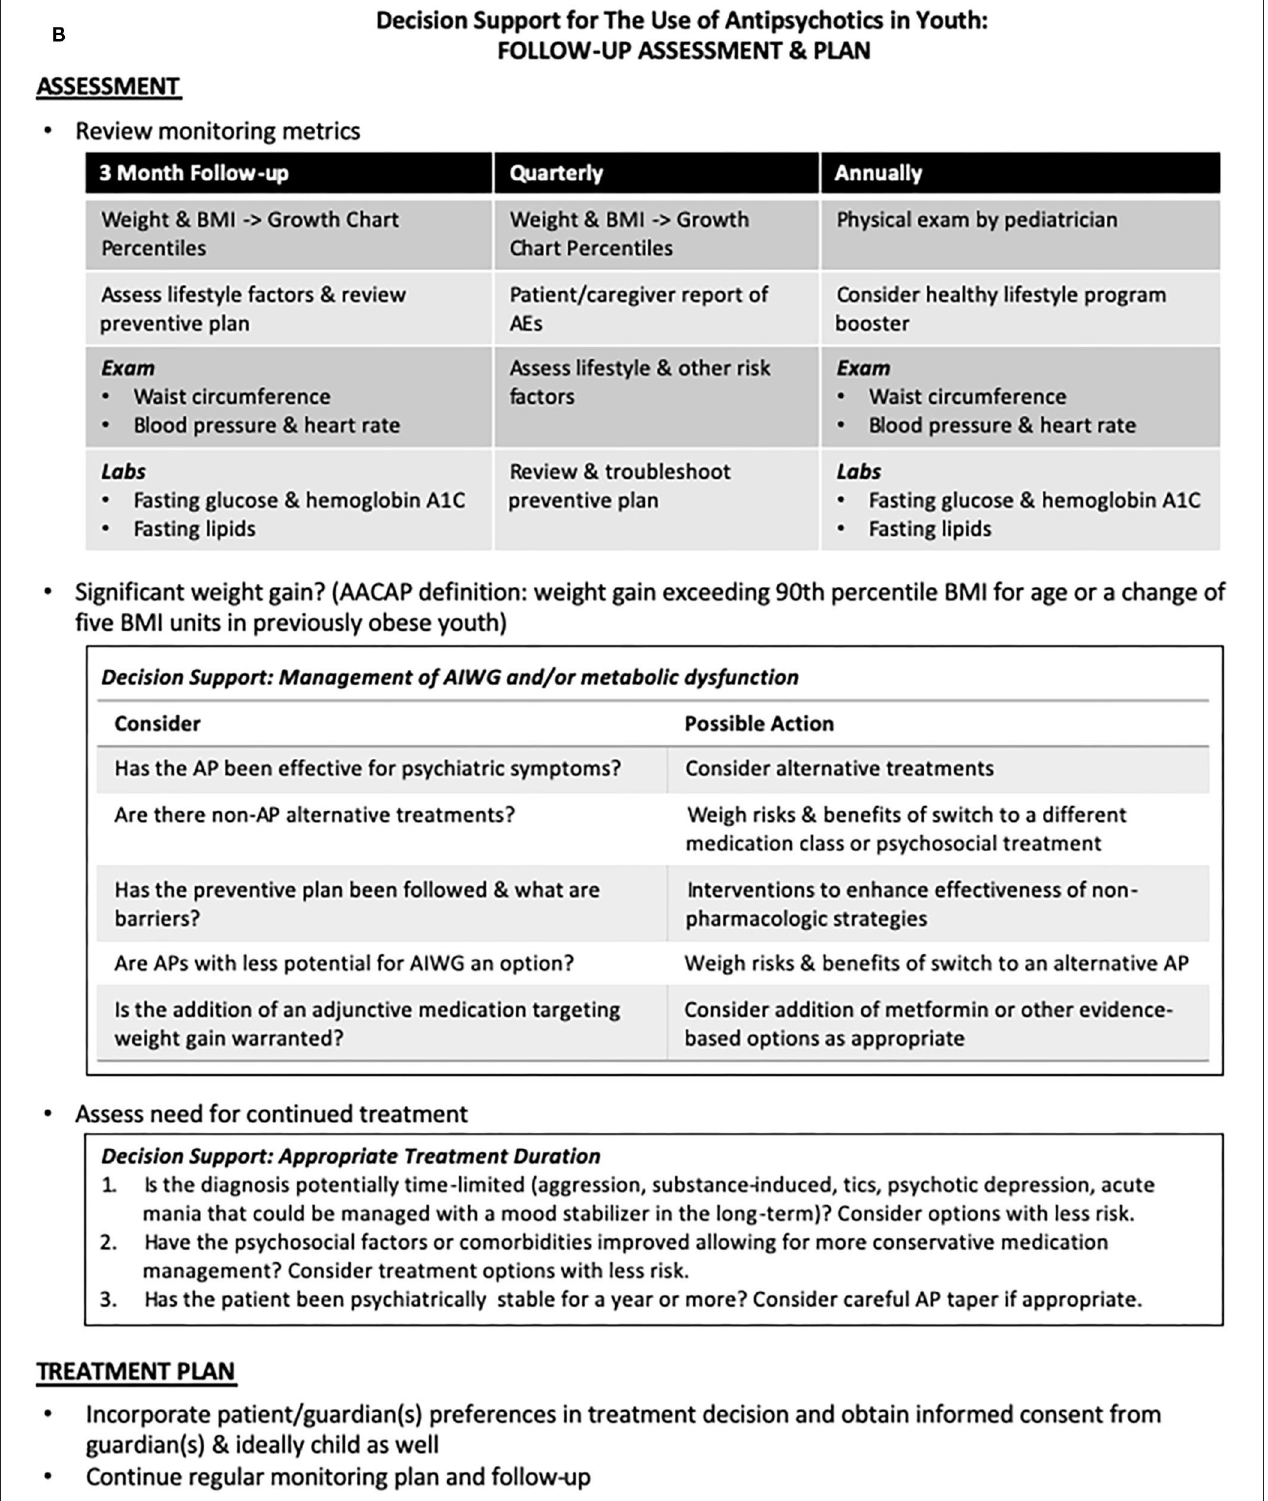
FIGURE 3 | (A,B) Clinical guideline and decision support for the assessment, prevention, and treatment of metabolic adverse effects of antipsychotic medications in youth. Adapted from the American Academy of Child and Adolescent Psychiatry (7) and American Psychiatric Association and American Diabetes Association Guidelines (70). (A) Initial Assessment and Plan. (B) Follow-up Assessment and Plan.